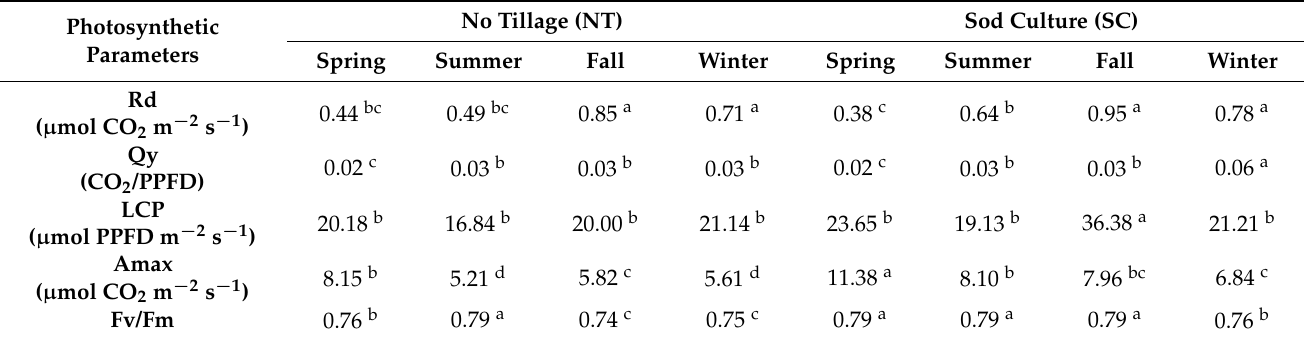
Table 2. Influence of NT and SC on Fv/Fm, Rd, Qy, LCP, Amax, and Fv/Fm of citrus grown in four seasons monitored